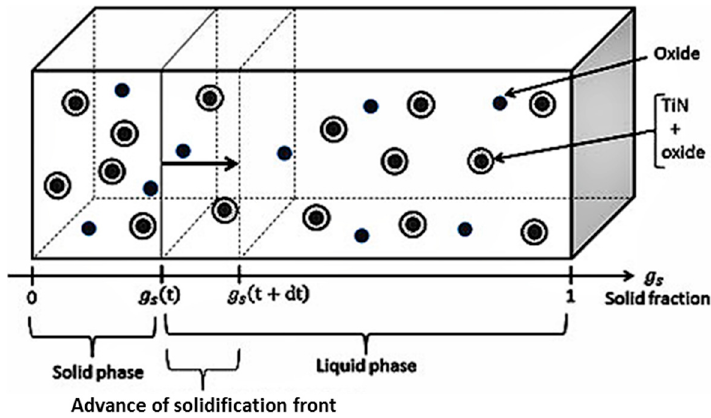
Figure 13. Schematic of TiN formation on pre-existing oxide during solidification [126].